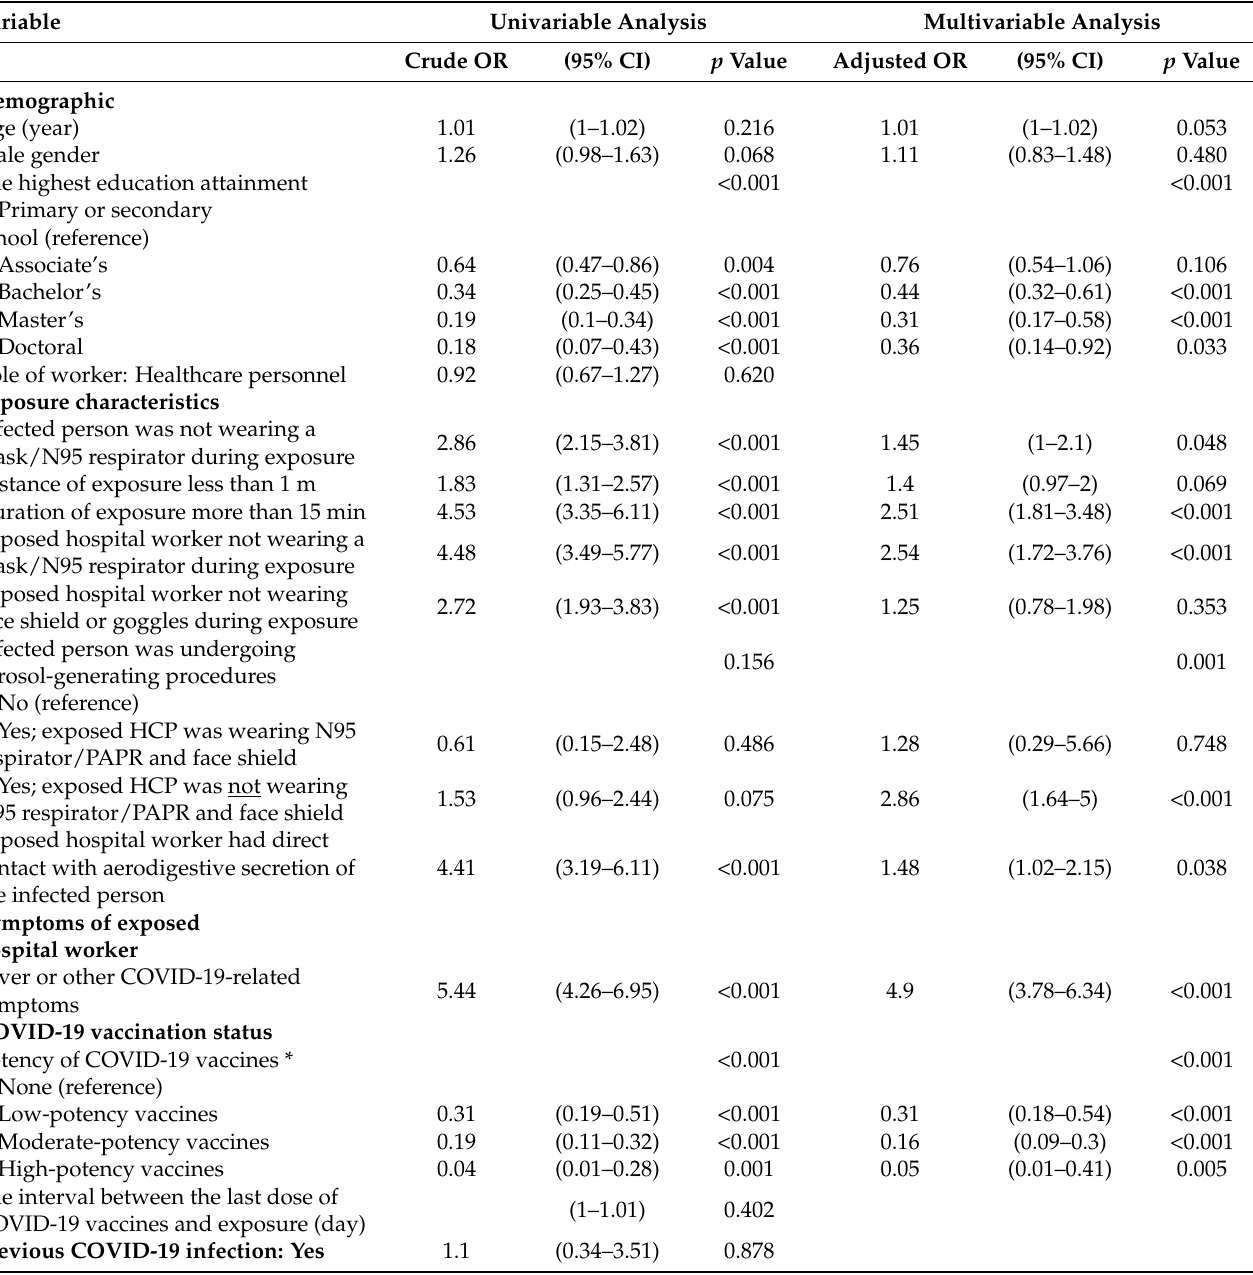
Table 2. Logistic regression analysis of variables associated with occupational SARS-CoV-2 infection among hospital